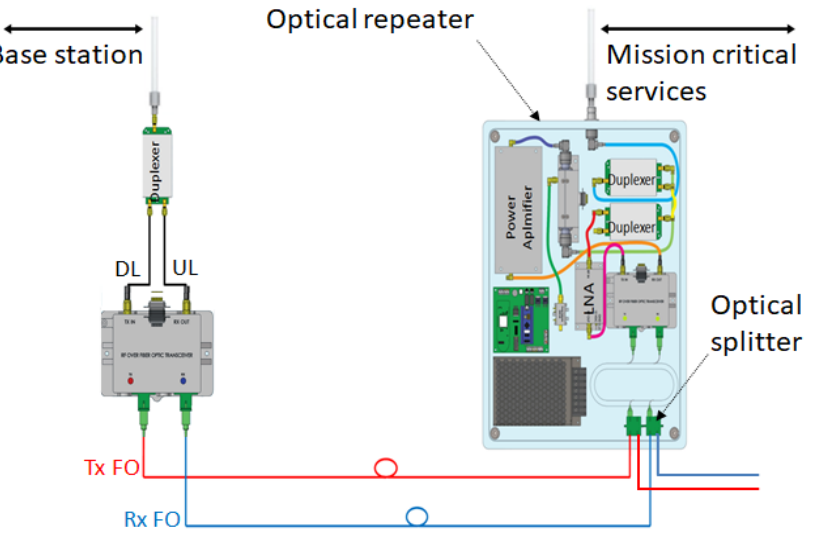
Figure 2. Pick-up modes: ( a ) by antenna, ( b ) direct connection to BS or repeater.